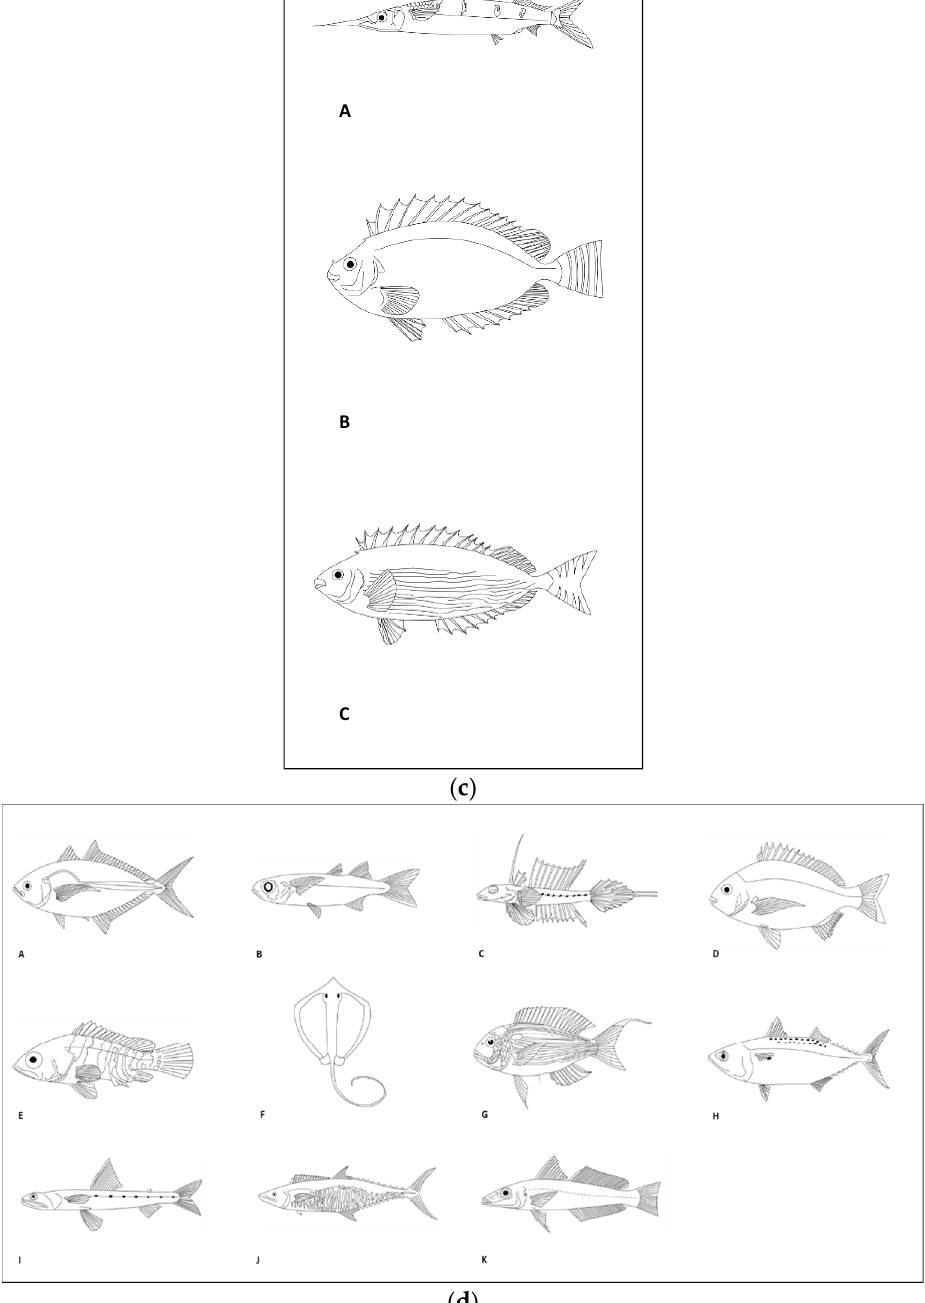
Figure 2. ( a ) Toxic harmful species, Lagocephalus sceleratus . ( b ) Omnivorous harmful species found in the Egyptian Mediterranean harbours examined through 1991 to 2021 A. Fistularia commersonii ; B . Nemipterus randalli ; C . Sargocentron rubrum. ( c ) Erbivores harmful species found in the Egyptian Mediterranean harbours examined from 1991 to 2021: A. Hemiramphus far ; B. Siganus huridus ; C. Siganus rivulatus . ( d ) Additional harmful species A. Alepes djedaba ; B. Atherinomorus lacunosus ; C. Callionymus filamentosus ; D. Crenidens crenidens ; E. Epinephelus malabaricus F . Himantura uarnak G . Nemipterus japonicus H . Rastrelliger kanagurta ; I. Saurida undosquamis ; J. Scomberomorus commerson ; K. Sillago sihama. Schematic images created by Sara Inglese.